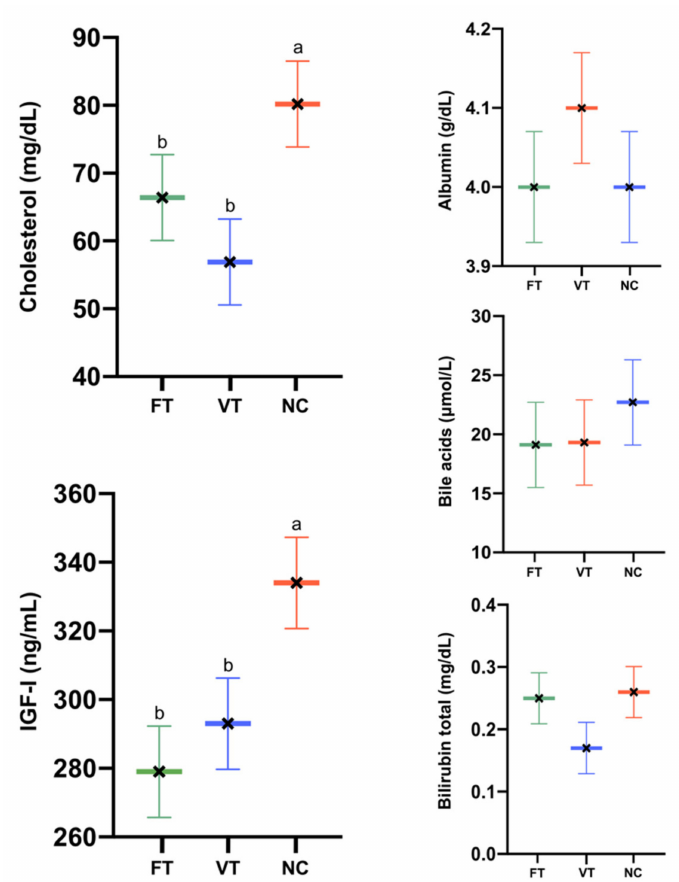
Figure 3. XY plot of serum biochemical marker for hepatic functionality, showing a significant di ff erence between groups for cholesterol and IGF-I. n = 20 biologically independent samples for each group. XY plot with di ff erent superscript letters are significantly di ff erent ( p ≤ 0.05). Data represent the least square means and standard errors of the